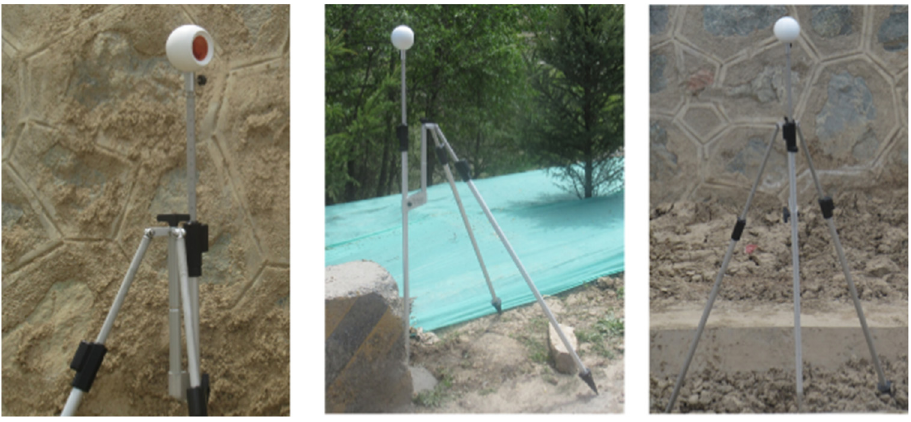
Figure 10. Prism ball target.